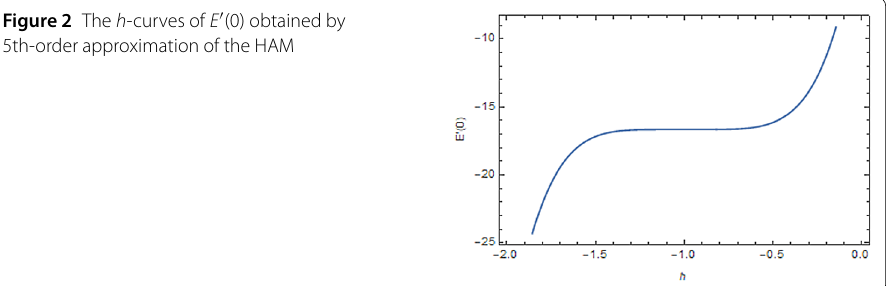
Figure 2 The h -curves of E (cid:10) (0) obtained